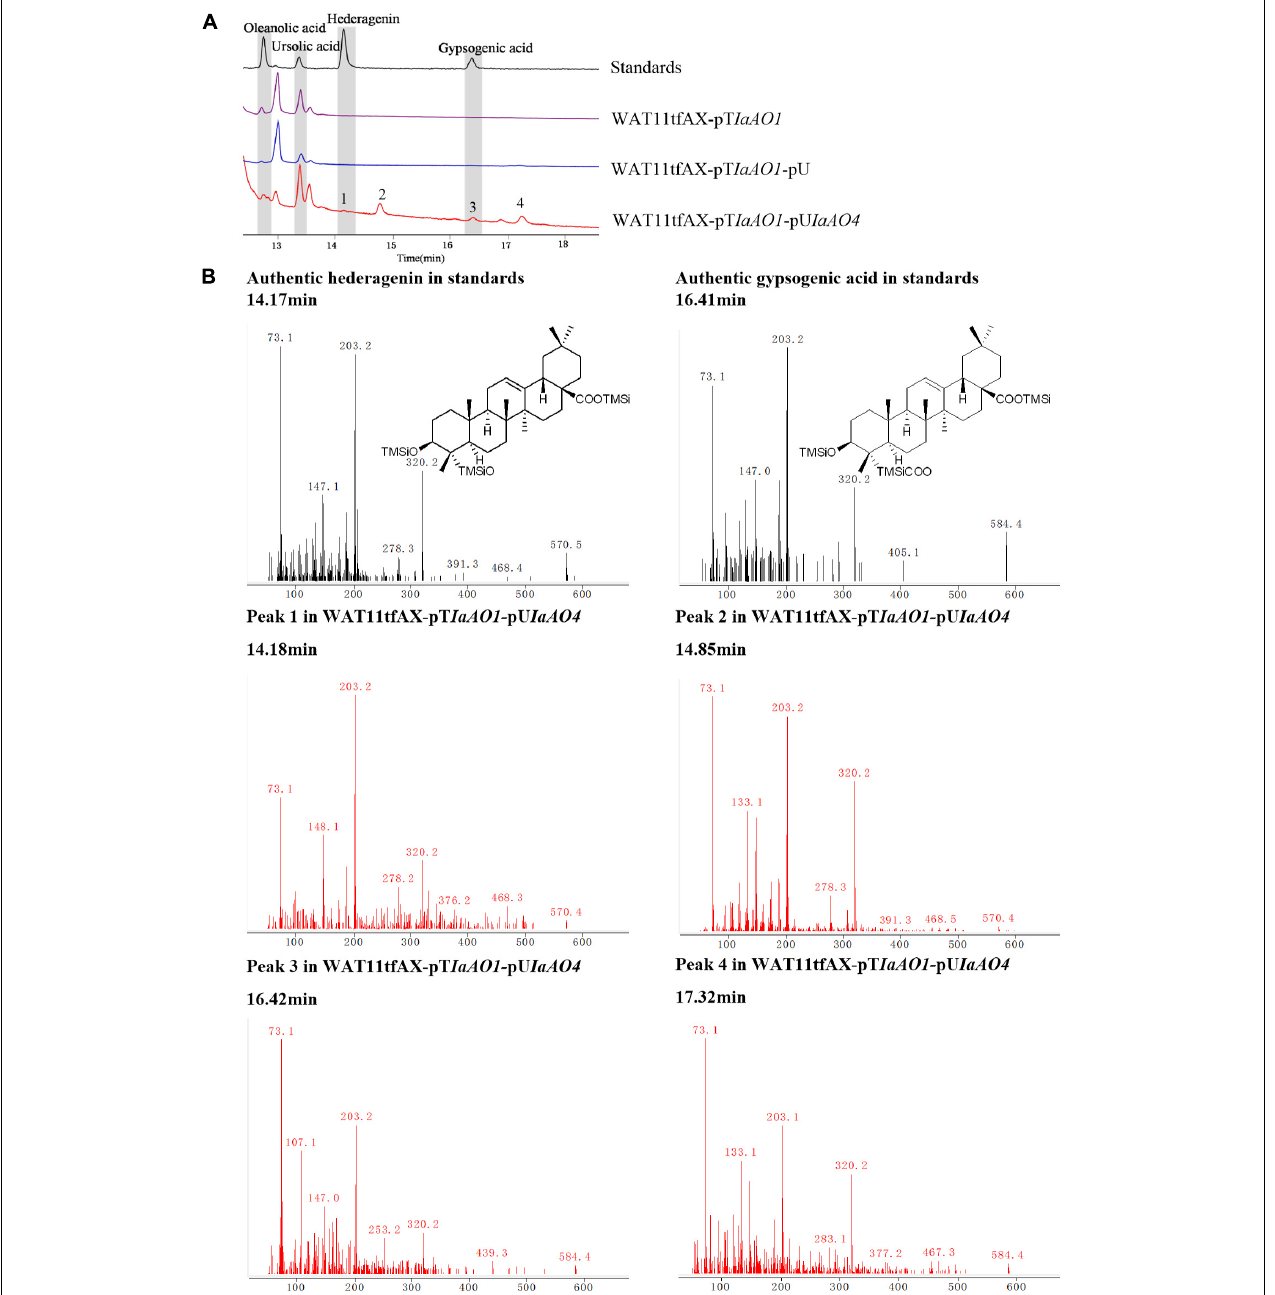
FIGURE 5 | GC-MS analysis of metabolites in WAT11tfAX-pT IaAO1 -pU IaAO4 . (A) Total ion chromatograms of mixed standard (black line), WAT11tfAX-pT IaAO1 (purple line), WAT11tfAX-pT IaAO1 -pU (blue line), and WAT11tfAX-pT IaAO1 -pU IaAO4 (red line). Major peaks were numbered. (B) Mass spectrum of hederagenin, gypsogenic acid and peak 1–4 from the GC profile shown in panel (A) . The retention time and mass spectra of peak 1 compared well with those of hederagenin. The retention time and mass spectra of peak 3 compared well with those of gypsogenic acid. In addition, the mass spectra of peak 2 was similar to that of hederagenin and the peak 4 was similar to that of gypsogenic